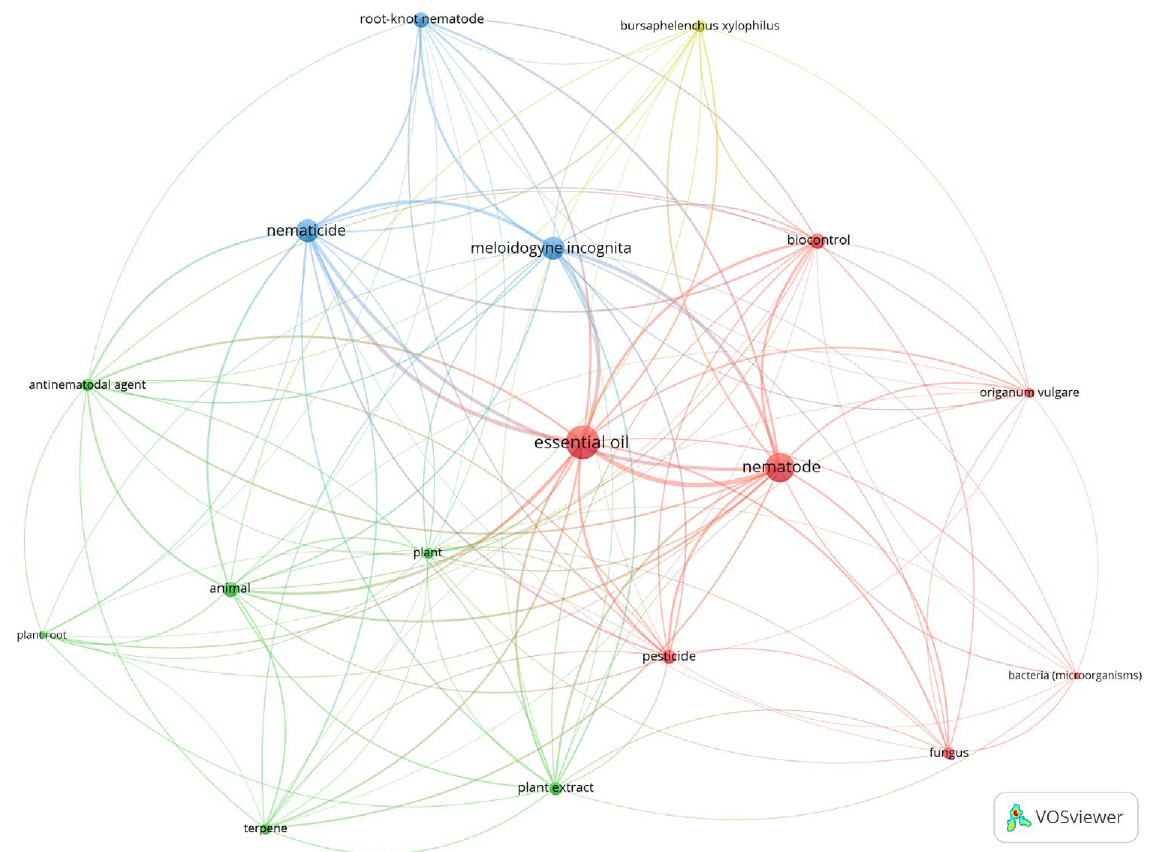
Figure 2. Network map of keyword co-occurrences for “essential oil” AND “nematodes”. The num- ber of keyword co- occurrences was 1322; a thesaurus file was necessary to reduce them to 1257. A total of 17 keywords met the threshold and were divided into 4 clusters (plot created by VOSviewer software).